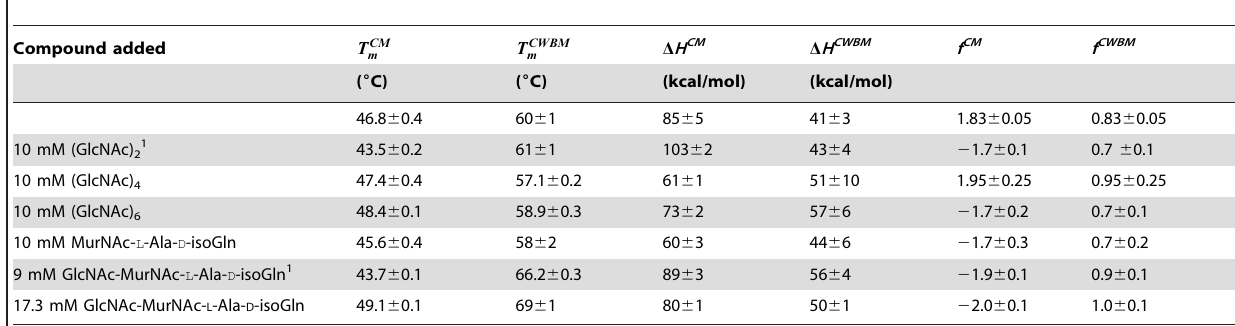
Table 4. Influence of (GlcNAc) n and muropeptides on the 290-nm CD denaturation profile of Cpl-7.